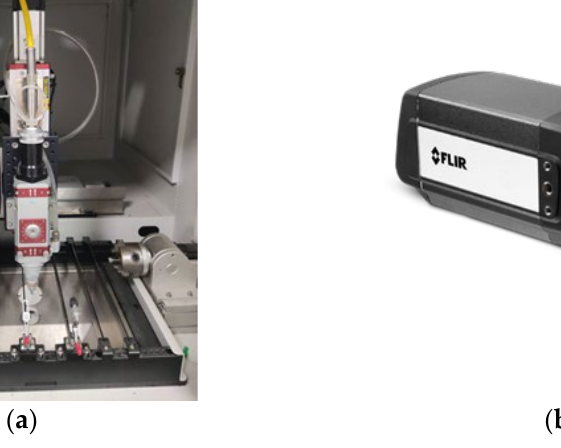
Figure 2. ( a ) Laser device; and ( b ) thermal infrared imager.